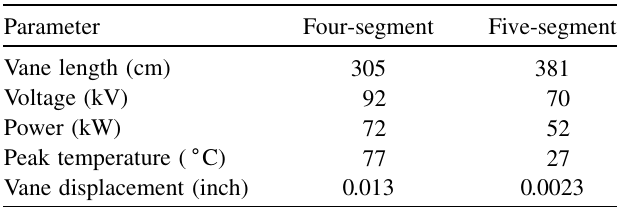
TABLE II. Comparison between the original four-segment and final five-segment designs for the ATLAS upgrade RFQ.